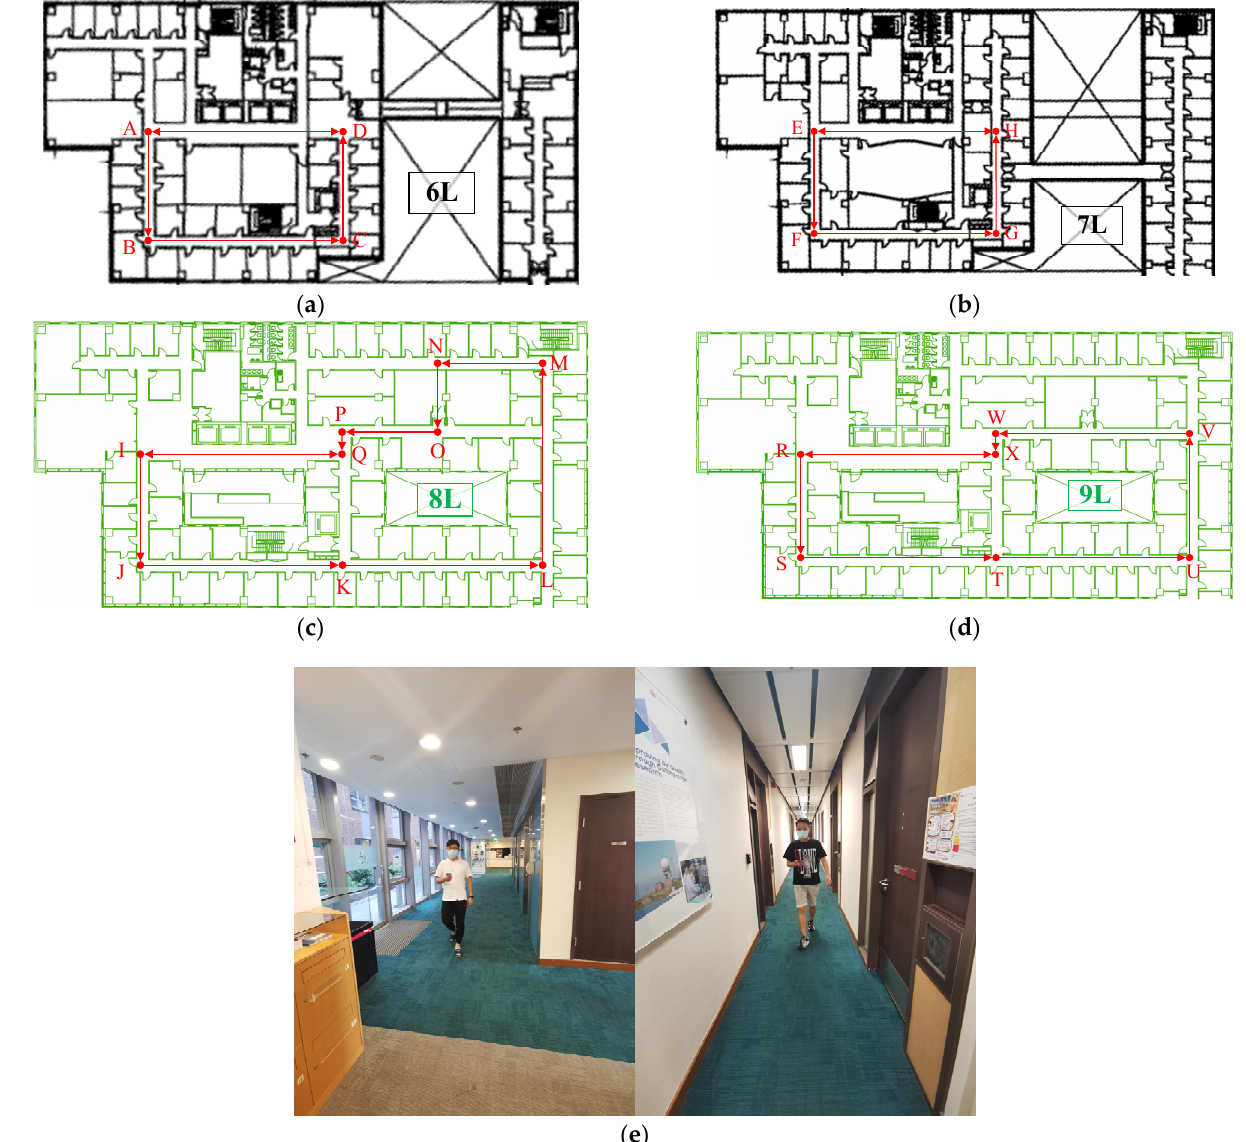
Figure 9. Multi-floor Contained Indoor Environment and Daily-life Data Collection. ( a ) Sixth Floor; ( b ) Seventh Floor; ( c ) Eighth Floor; ( d ) Ninth Floor; ( e ) Daily-life Data